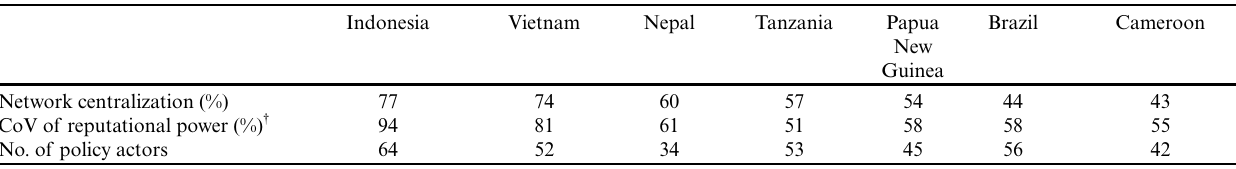
Table 1 . Concentration of power in national REDD+ policy